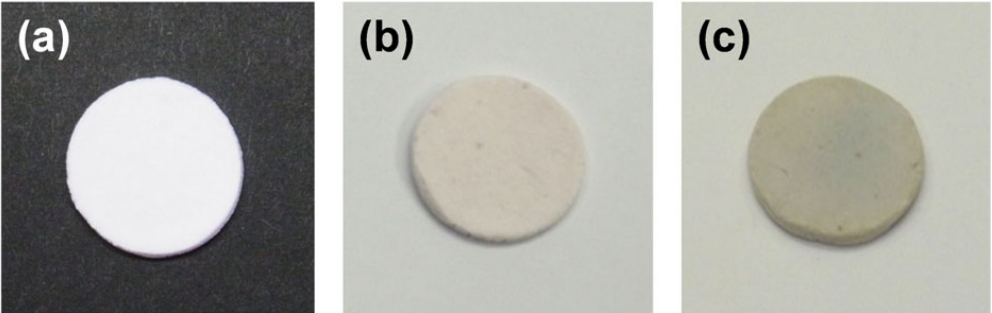
Figure 4. Optical images of ( a ) the original ZnO paper, ( b ) AuNPs @ ZnO paper and ( c ) AuAgNPs @ ZnO paper. The paper composite size is 1.8 × 10 2 mm 2